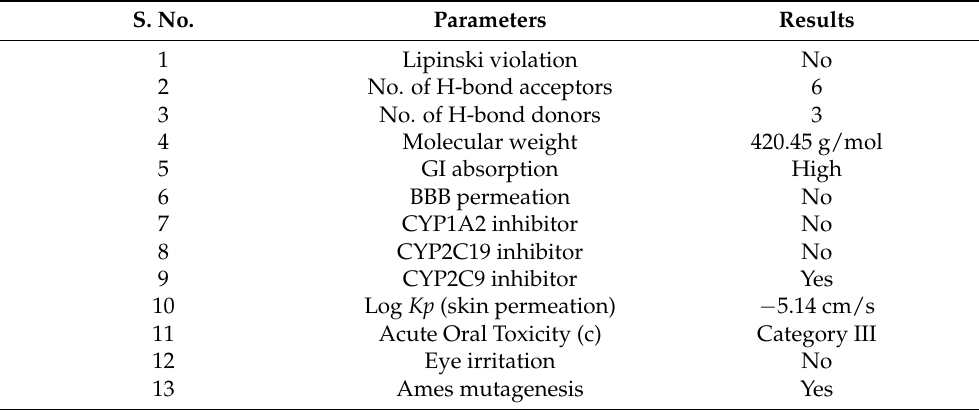
Table 3. Important ADME and toxicological properties of